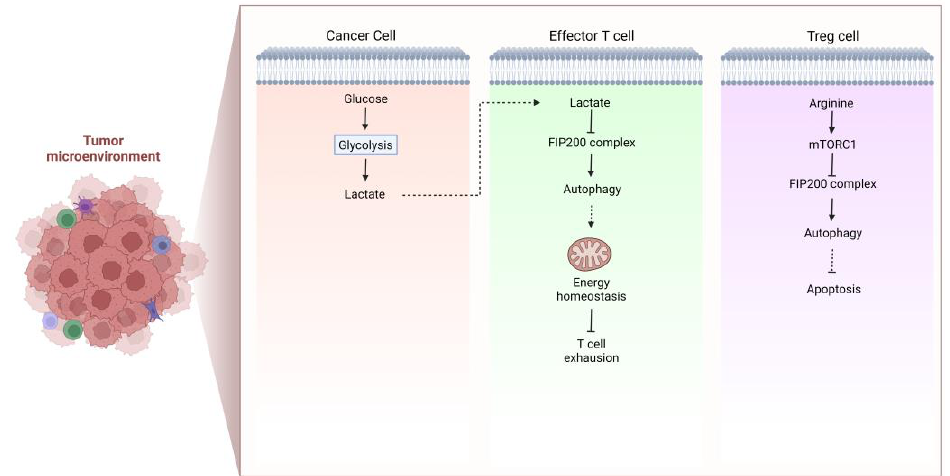
Figure 2. The formation of immunosuppressive TME. Cancer cell-derived lactate lowers FIP200 expression and attenuates autophagy, which is pivotal for energy homeostasis of effector T cells, thus facilitating T cell exhaustion and formation of immunosuppressive TME. In Treg cells, decreased intracellular arginine suppresses mTOR, leading to autophagy activation that is responsible for Treg cell survival. As a consequence, the function of Treg cell is improved to form the immunosuppres- sive TME.